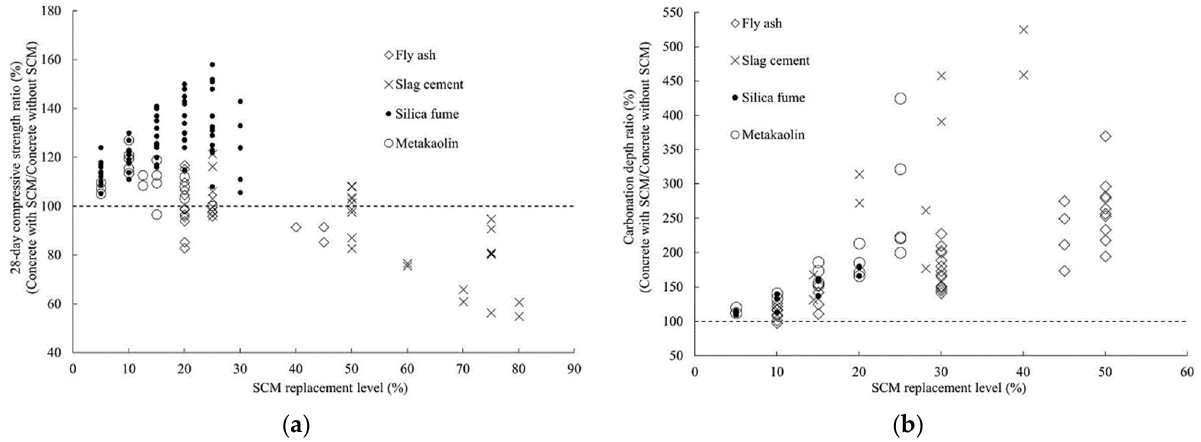
Figure 1. Influence of SCM replacement level on ( a ) compressive strength ( b ) carbonation depth of concrete [27].